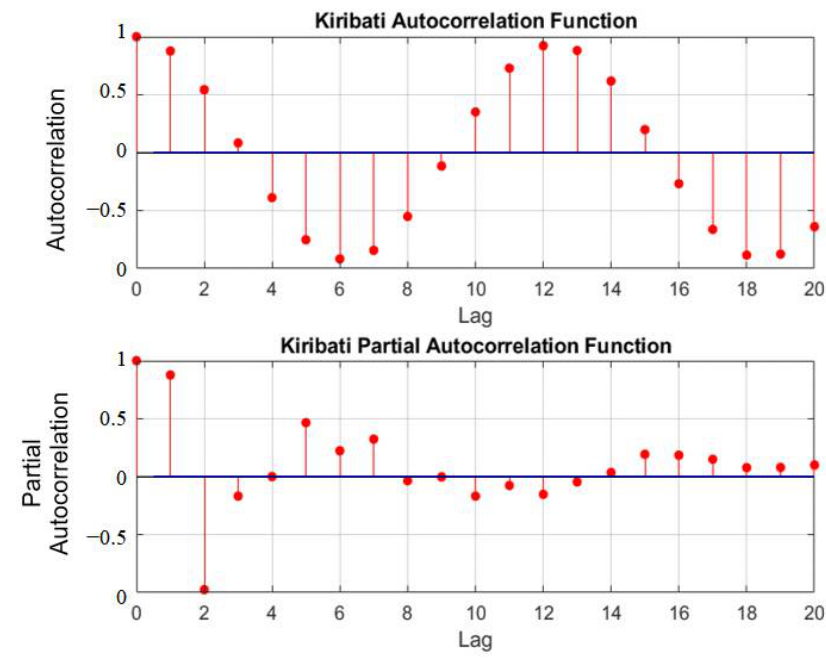
Figure 2. ACF and PACF for Kiribati time series.